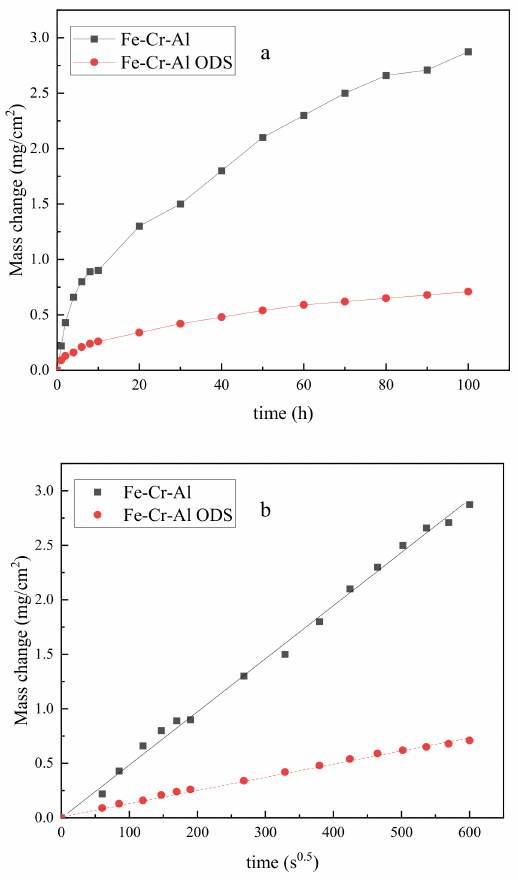
Figure 1. ( a ) Mass change curves and ( b ) the linearity between mg/cm 2 and s 0.5 of studied alloys in air at 1200 ◦